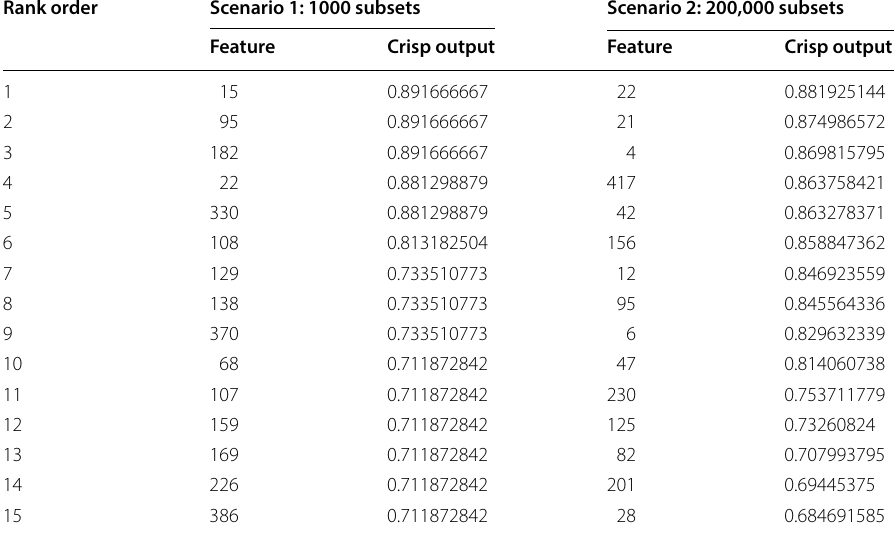
Table 7 Comparison of best feature categorization, 2-level input membership